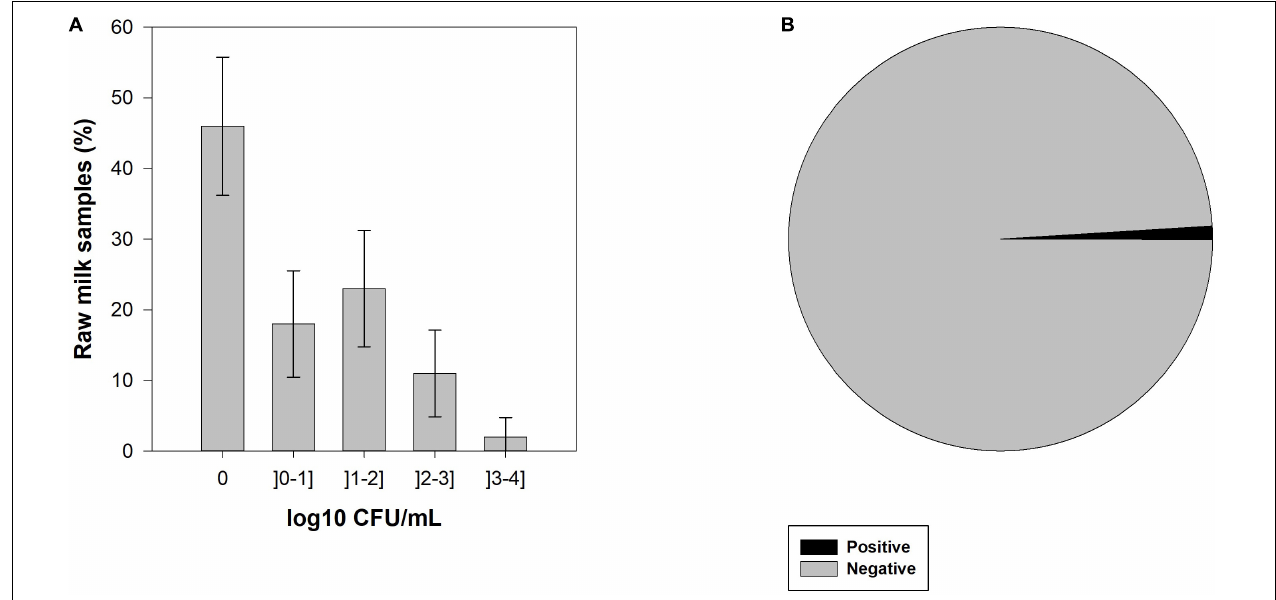
FIGURE 1 | (A) Enumeration of bulk tank milk samples with coagulase-positive staphylococci (CPS) by colony forming units (CFU) categories and its 95% confidence interval (CI), and (B) prevalence of staphylococcal enterotoxins (SEs) in raw cow’s milk samples from bulk cooling tanks of 100 dairy farms located in the main dairy basin of mainland